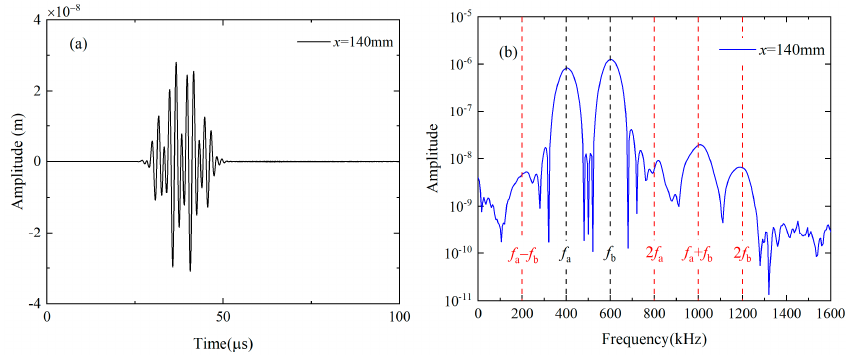
Figure 4. Typical displacement along y axis ( a ) received on the surface of the plate at x = 140 mm in Case 1 and its frequency spectrum ( b ) obtained by the FFT.